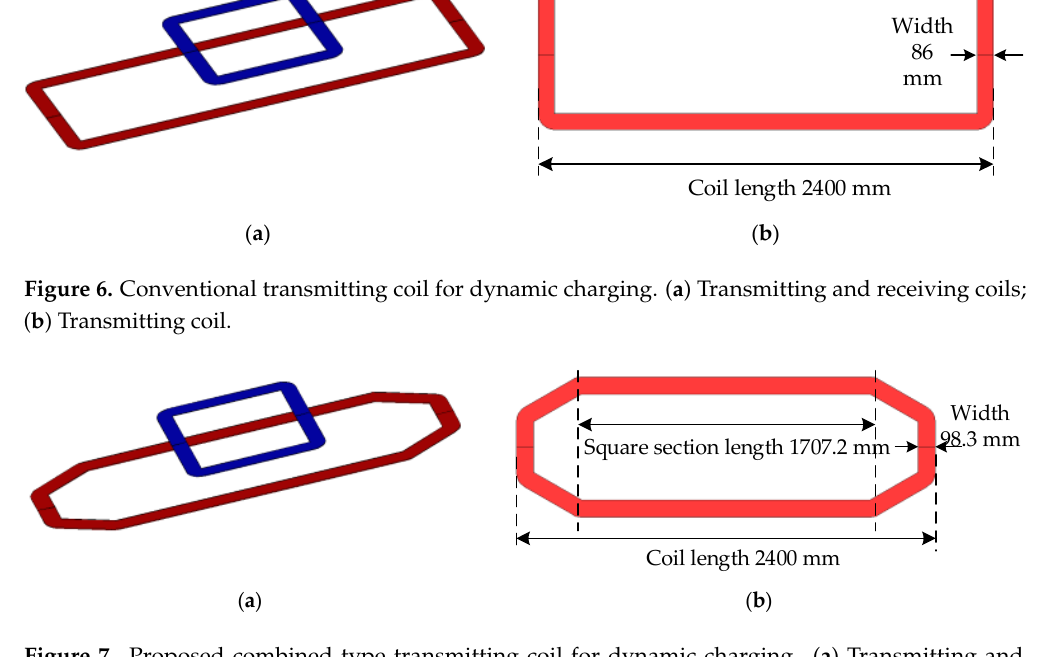
Figure 7. Proposed combined type transmitting coil for dynamic charging. ( a ) Transmitting and receiving coils; ( b ) Transmitting coil. Table 2. Design specifications of transmitting coils for EV dynamic charging.